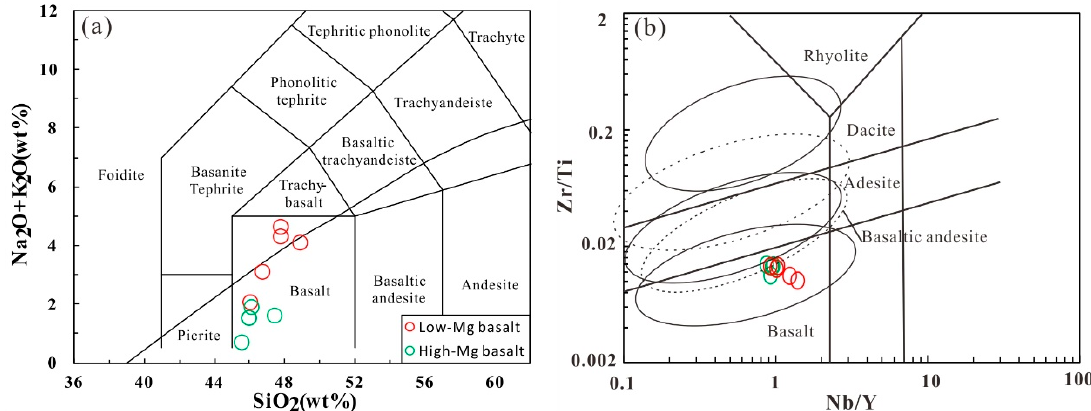
Figure 3. ( a ) Total alkali (Na 2 O + K 2 O) versus SiO 2 (TAS); ( b ) Nb/Y versus Zr/Ti(after Le Maitre et al. [65]. The diagram for sub-alkaline rocks is from Pearce 1996 [66]).